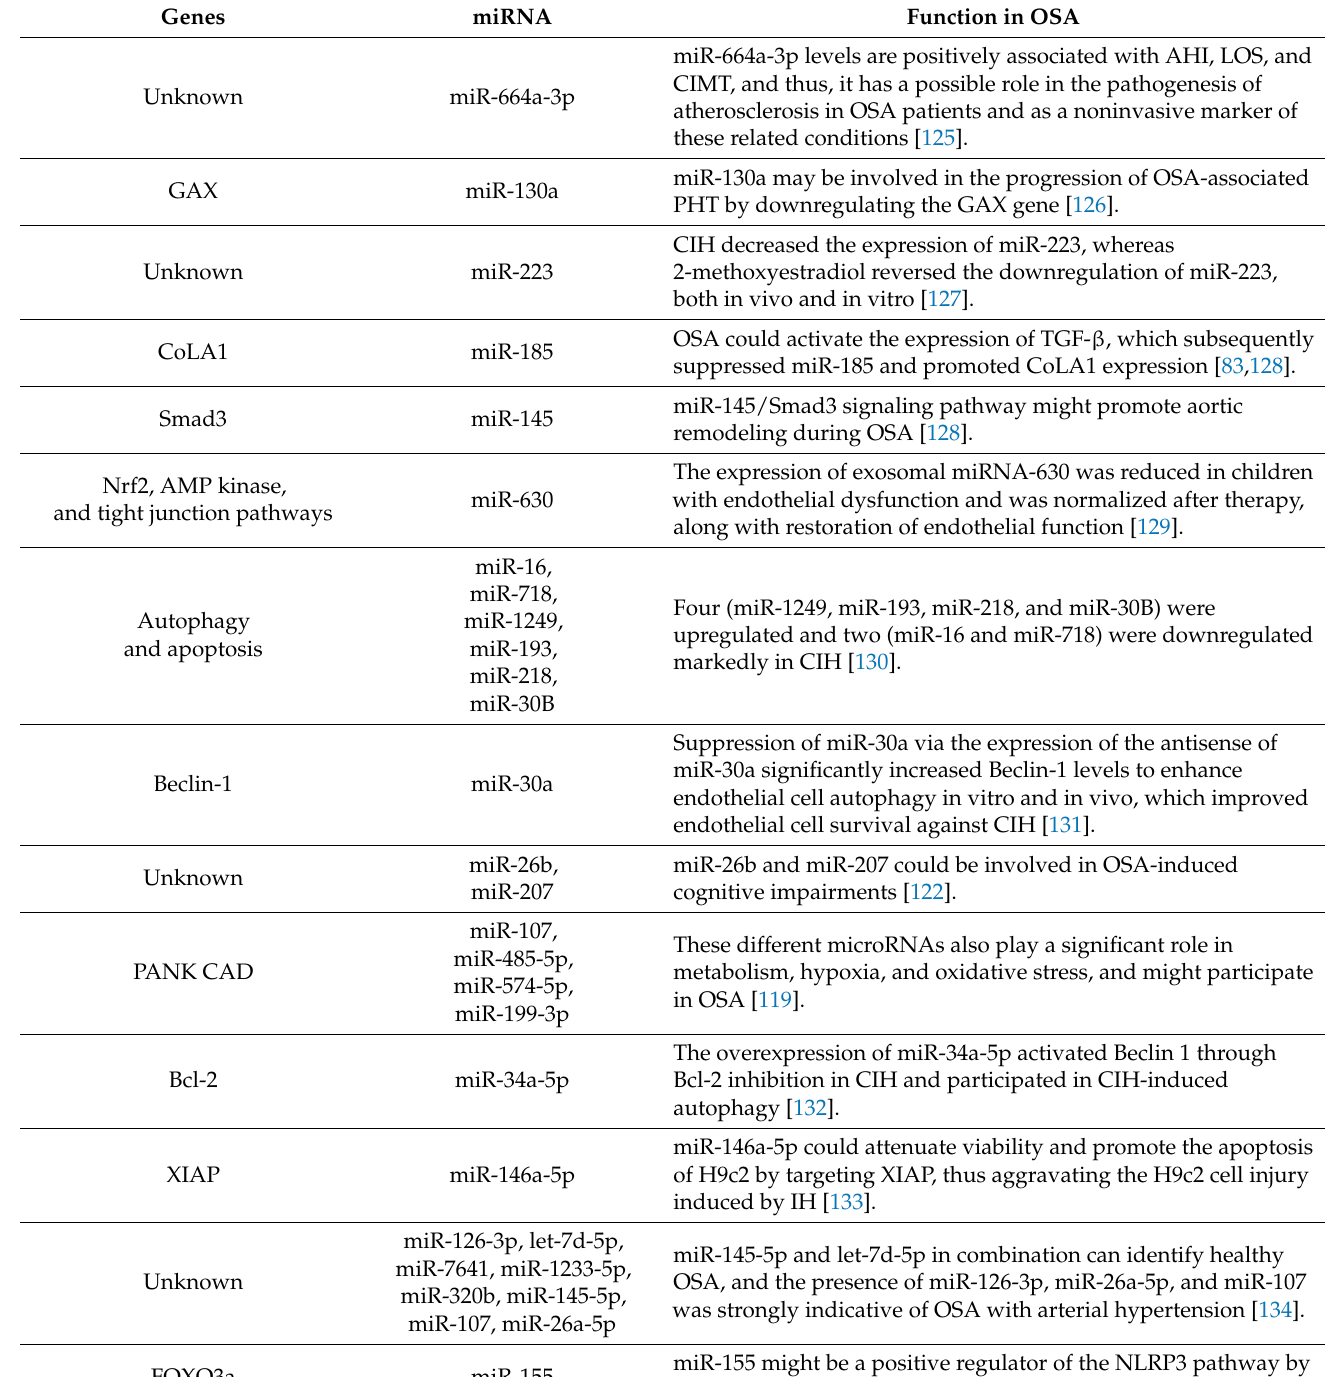
Table 2. miRNAs in